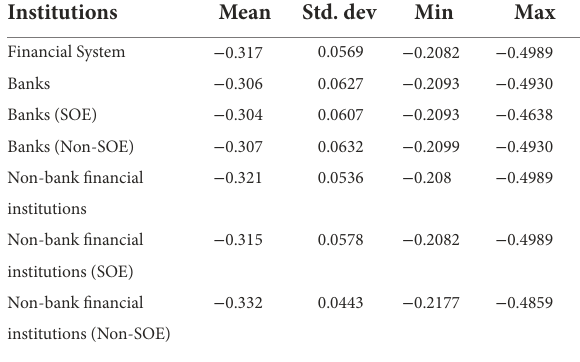
TABLE 1 Financial institutions systemic risk ( ∆ CoVaR).